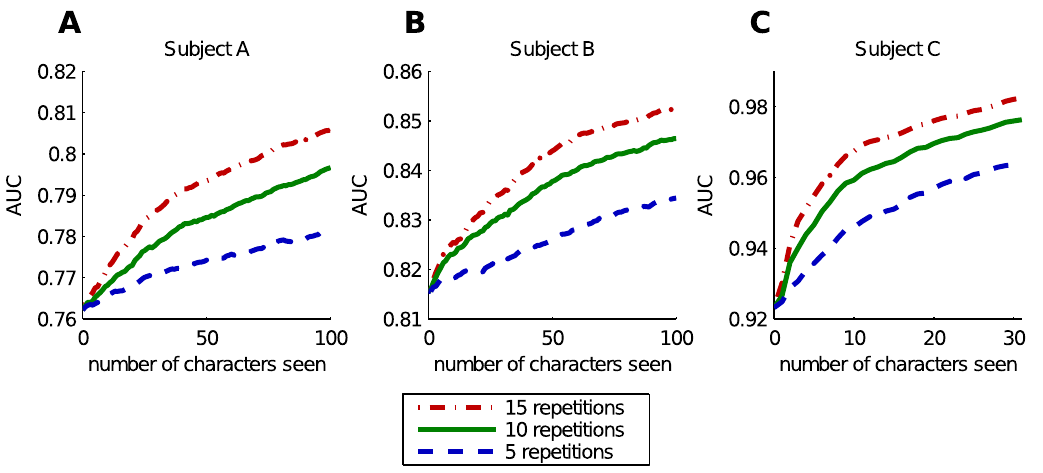
Figure 6. Classifier improvement trough adaptation. The initial classifier was trained unsupervisedly on the train set with 5 repetitions. The classifier was adapted to the EEG by feeding it the EEG character by character and performing EM on the original training set combined with the new EEG.